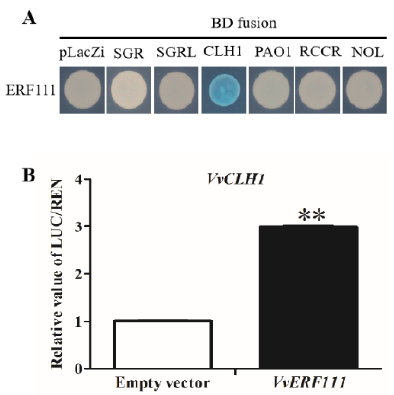
Figure 4. Interaction of the VvERF111 protein with the promoter of VvCLH1 . ( A ) Yeast one hybrid assays to detect the binding of VvERF111 on the promoters of chlorophyll degradation genes. ( B ) Dual-LUC experiment to detect the regulation of the VvCLH1 promoter by VvERF111, and the pSAK277 empty vector co-transformed with promoter of VvCLH1 was used as negative control. Data represented mean ± SE from three independent biological replicates; ** represents significance at p < 0.01.